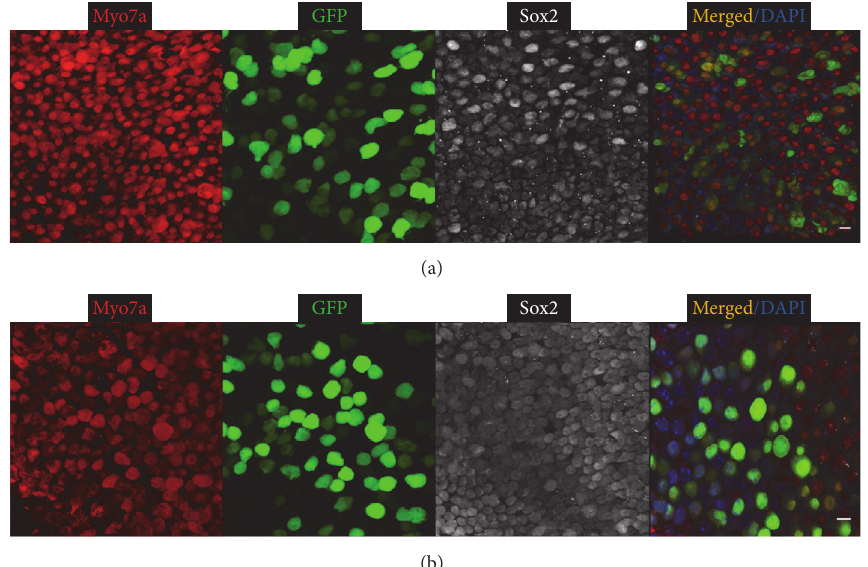
Figure 7: Ad-GFP-Baylor (a) and Ad-GFP-VB (b) transduce supporting cells and hair cells in the mouse utricle when injected at P0. Representative confocal images of whole-mount fluorescent immunolabeling of the utricle. Scale bars: 10 𝜇 m.